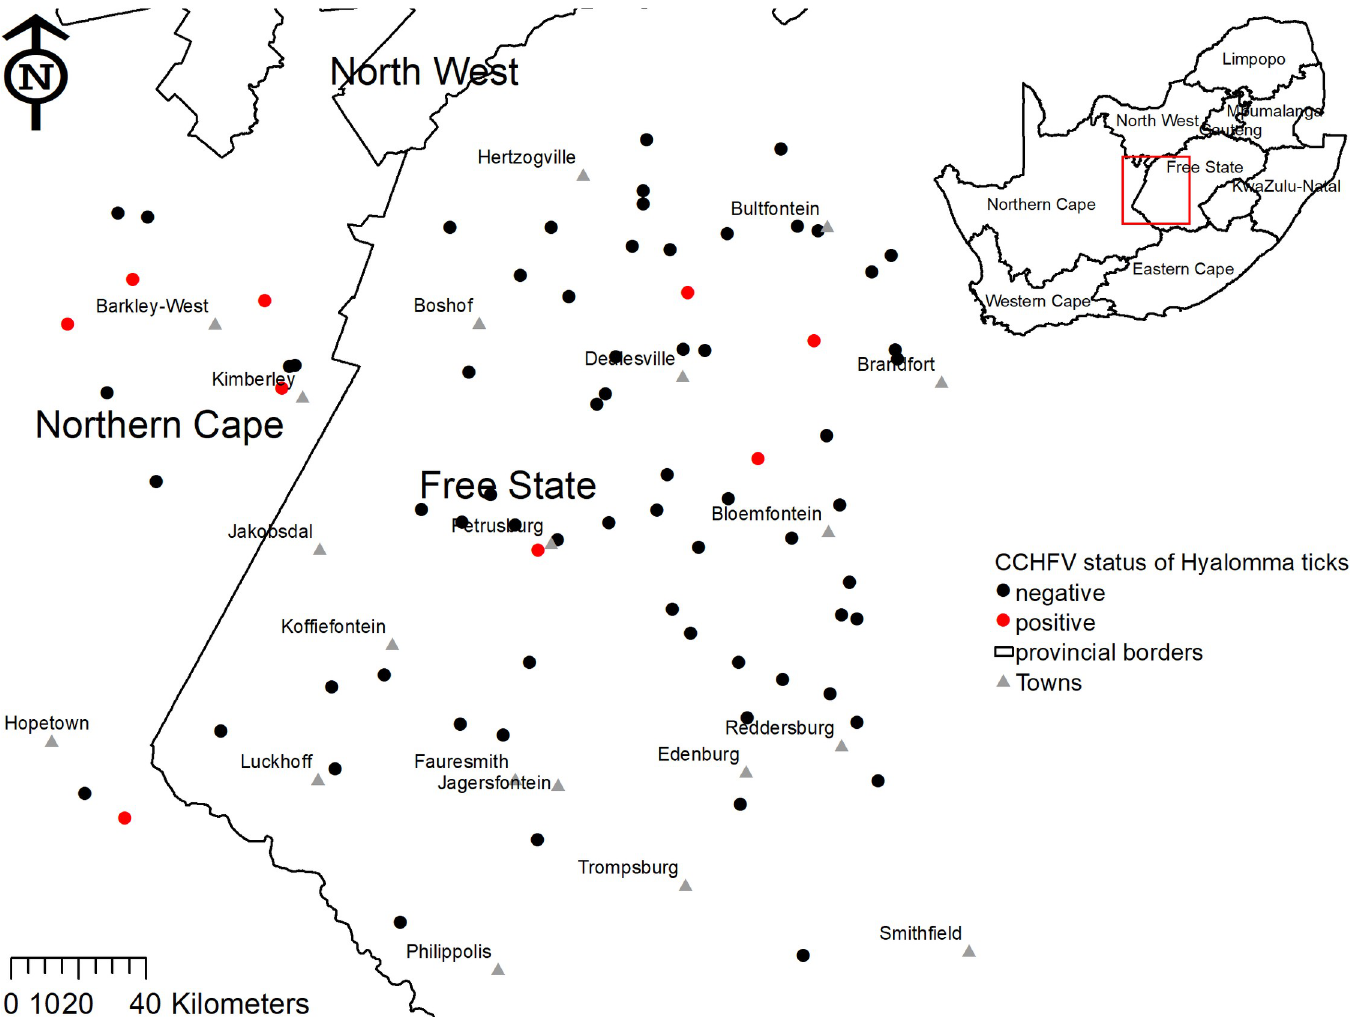
Fig 5. Crimean-Congo haemorrhagic fever virus status amongst cattle Hyalomma spp. ticks on farms in Free State and Northern Cape Provinces. The map was constructed for the manuscript in Esri ARCGIS 10.2 using country and provincial boundaries from Municipal Demarcation Board [23] and National Geo-Spatial Information [24], coordinates of sampling sites and towns collected during the survey data available under a Creative Commons Attribution (CC BY 4.0) license.